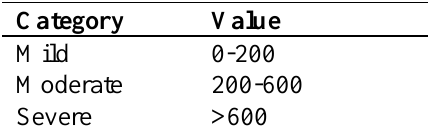
Table 8. Classifications of Brinkman Index Category